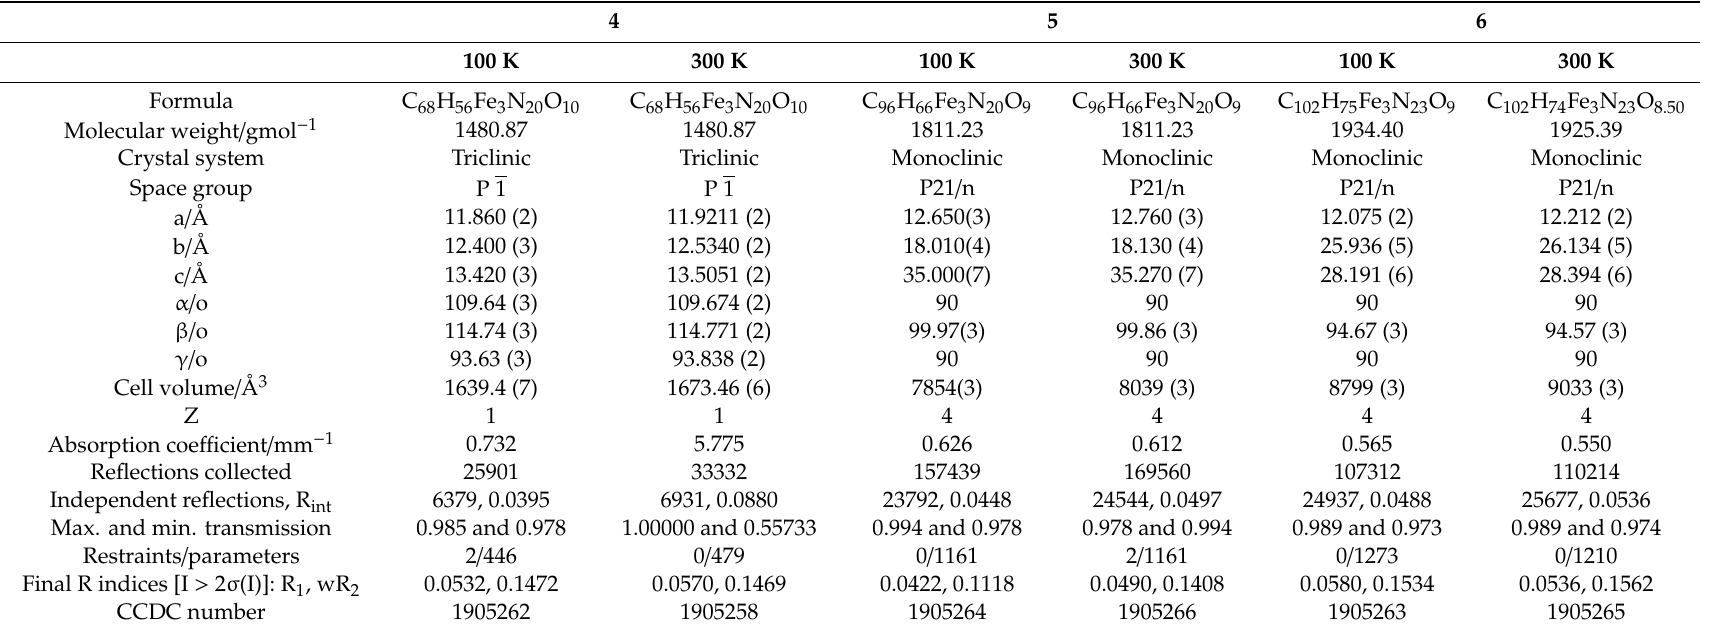
Table 1. Crystallographic data and structure refinement for 4 – 6